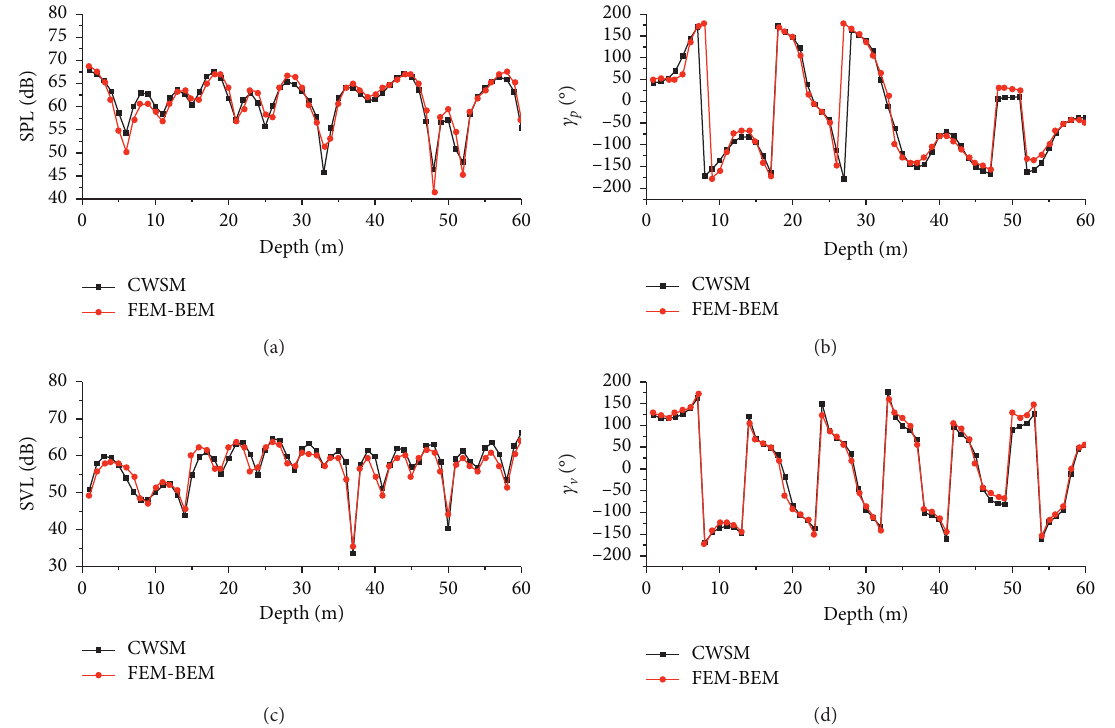
Figure 7: Comparisons of the CWSM with the FEM-BEM at the frequency of 190Hz. (a) SPL. (b) c � 1600kg/m 3 ). ρ 1